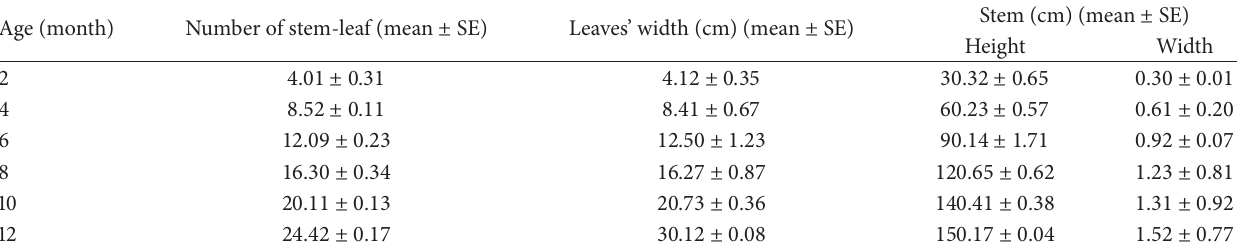
Table 3: Growth of stems and leaves of different ages.